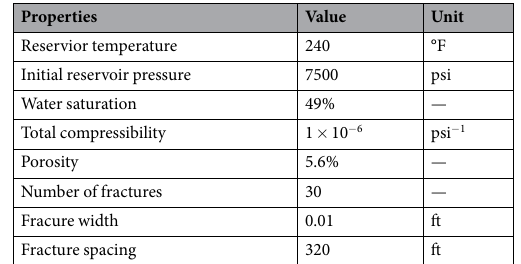
Table 3. Reservoir and fracture properties from middle Bakken for simulation